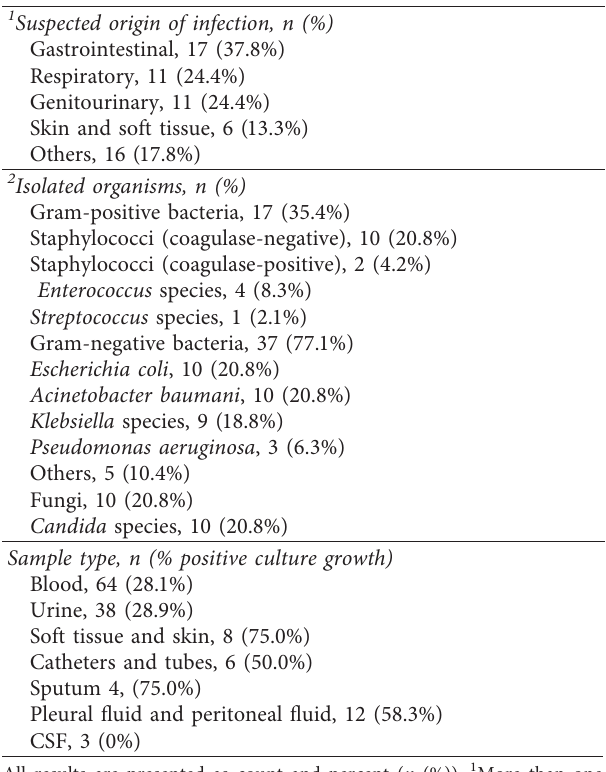
Supplementary Table 1: vital signs of the study cohort di- vided by outcome. Supplementary Table 2: vital signs and